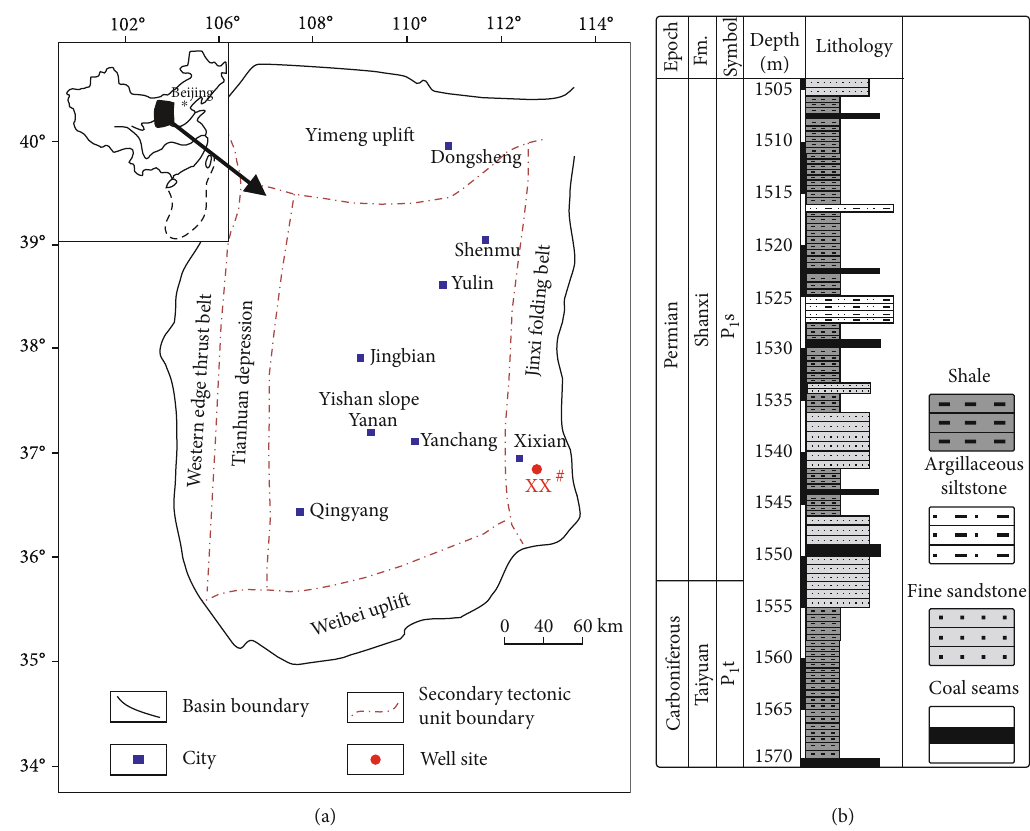
Figure 1: (a) Location of the study area and the substructure zones of the Ordos Basin (modi fi ed from Duan et al. [25]). (b) Petrological characterization of the drilled section of XX # well that corresponds to the cored section samples in this